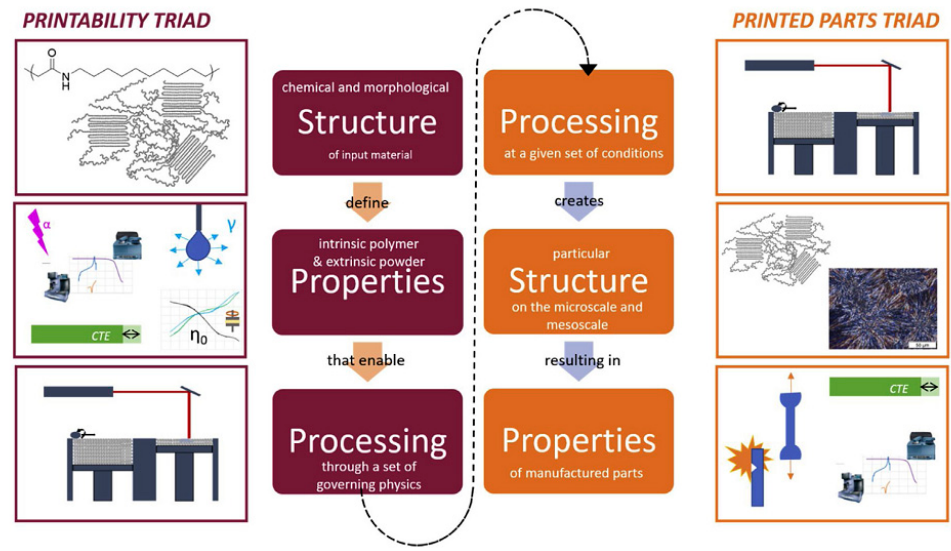
Figure 4. The two, key relationship triads of polymer PBF manufacturing [22].